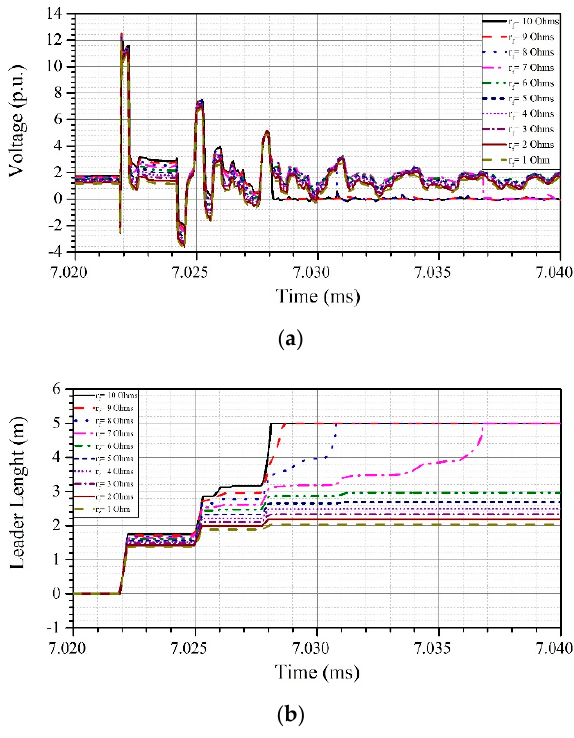
Figure 28. Lightning strike on the top of twr 2S . ( a ) Voltage across insulators of the positive pole of twr 2S according to footing impedance. ( b ) Leader propagation between the insulator gap of twr 2S according to footing impedance.